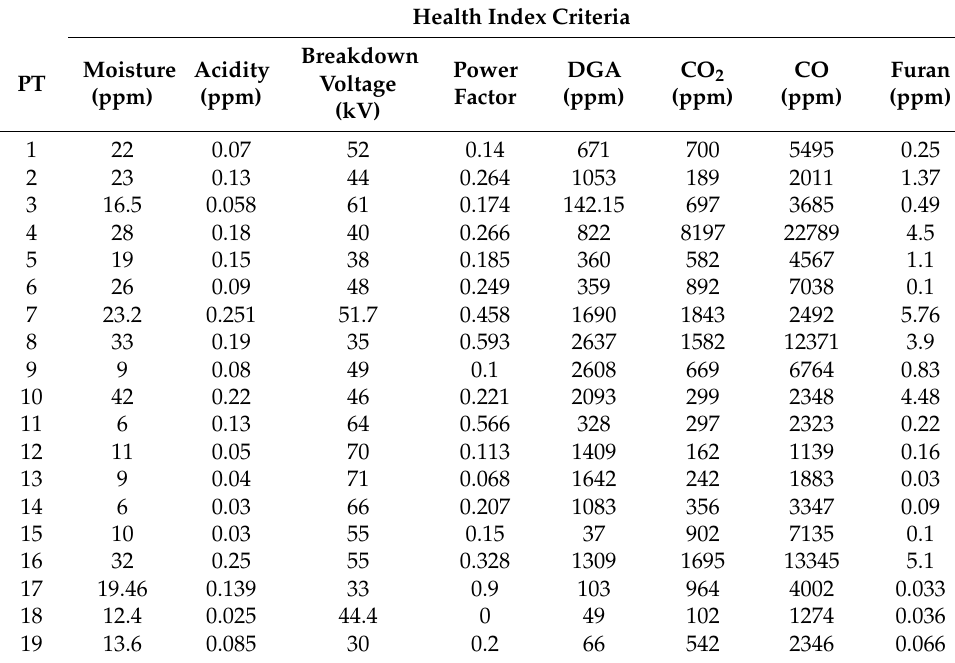
Table 2. Transformers fleet diagnostic test results.